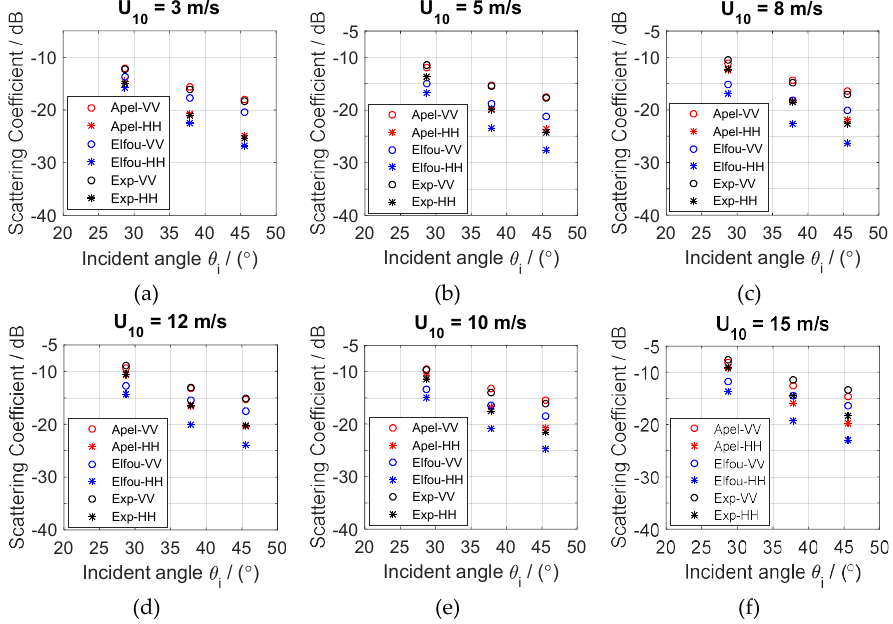
Figure 9. Comparisons of simulated backscattering based on Apel and Elfouhaily spectra with Aquarius data in the upwind direction at incident angles of 28.7, 37.8, and 45.6 degrees for L-band at wind speeds of 3, 5, 8, 10, 12, and 15 m/s, respectively. ( a ) 3 m/s; ( b ) 5 m/s; ( c ) 8 m/s; ( d ) 10 m/s; ( e ) 12 m/s; ( f ) 15 m/s.